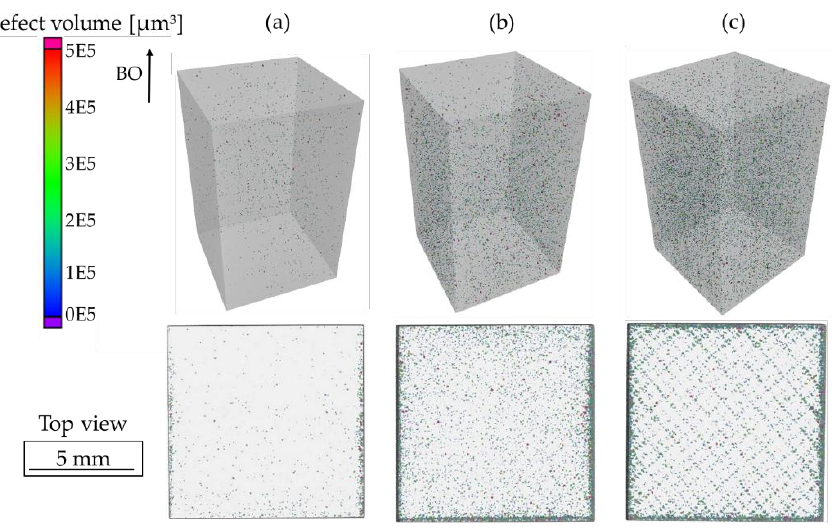
Figure 4. 3D pore analysis with related top views of material: ( a ) 0° specimen; ( b ) 45° specimen; and ( c ) 90° specimen.